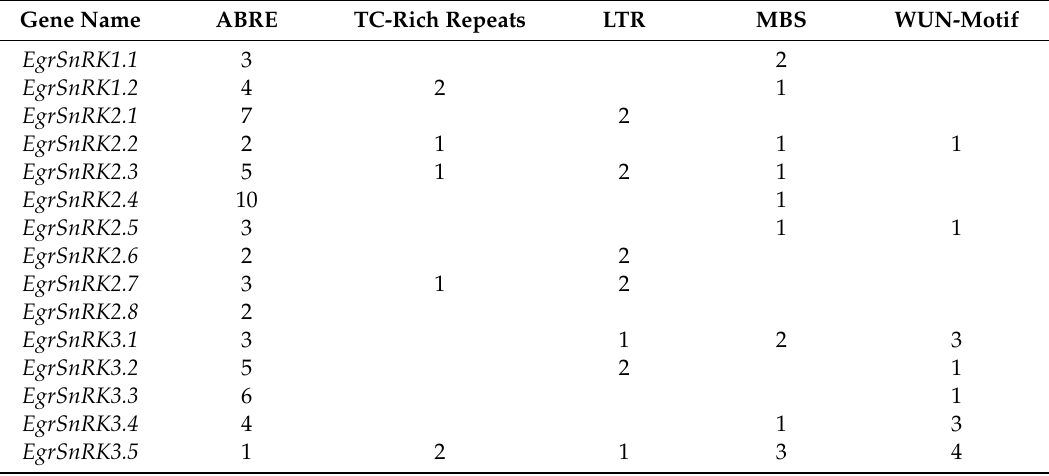
Figure 6. Cis-acting elements analysis of EgrSnRK genes in the promoter region. Gray lines represent promoter regions. Di ff erent color boxes represent di ff erent cis-acting elements. The ABRE elements are involved in the abscisic acid response, and TC-rich repeats elements are involved in defense and stress responses, the LTR elements are involved in low-temperature responses, the MBS elements are involved in drought-inducibility and the WUN-motif elements are involved in wound-responsive. Table 3. Numbers of each of the ABRE, TC-rich repeats, LTR, MBS and WUN-motif elements are